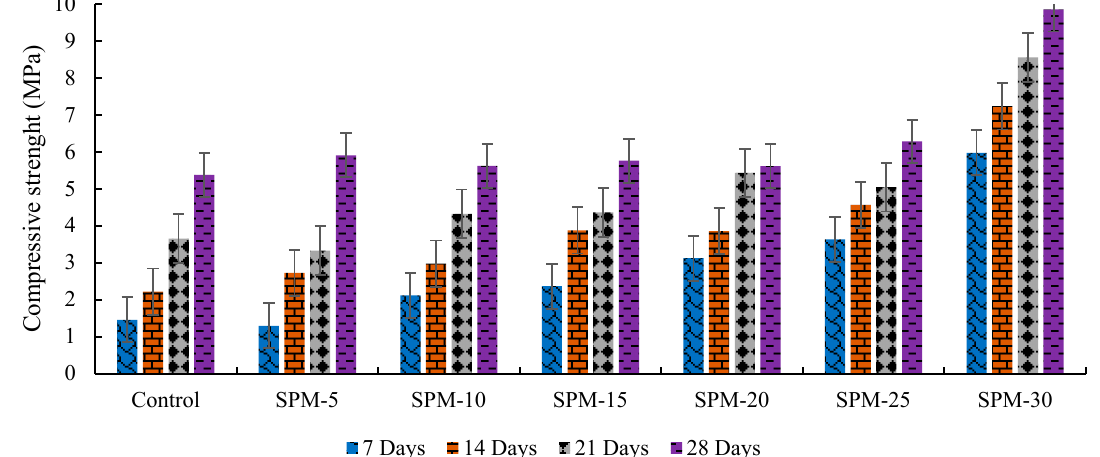
Figure 5. Rebound hammer strength results of SPs-based mortar.